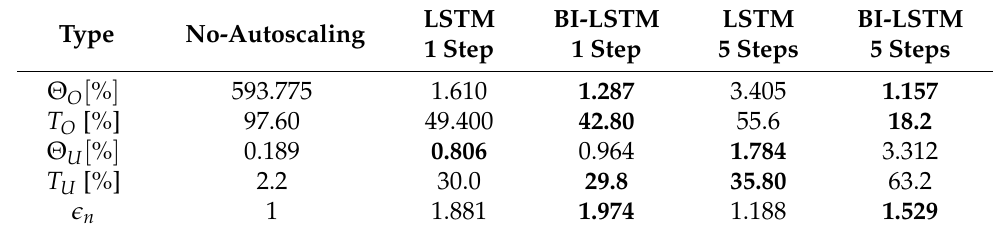
Table 6. Evaluation of auto-scaler.